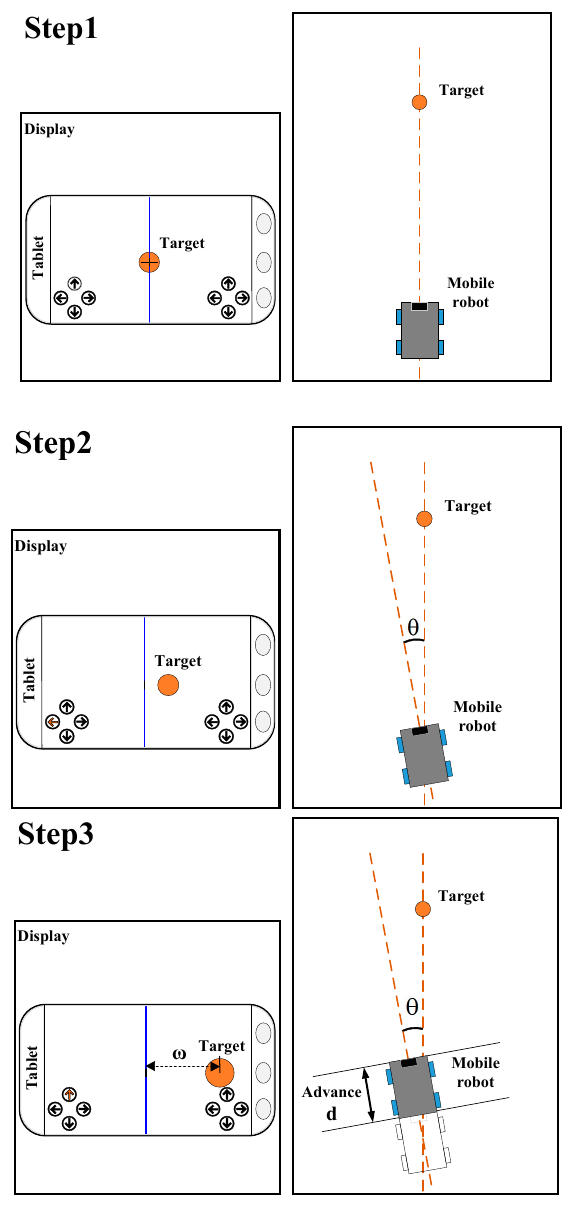
Figure 6. Flow of robot movement.